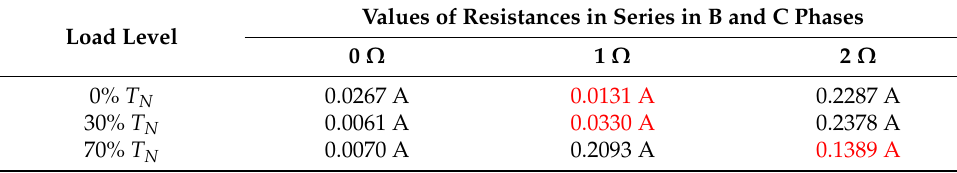
Table 7. The amplitude of the 100 Hz component based on spectrum analysis.